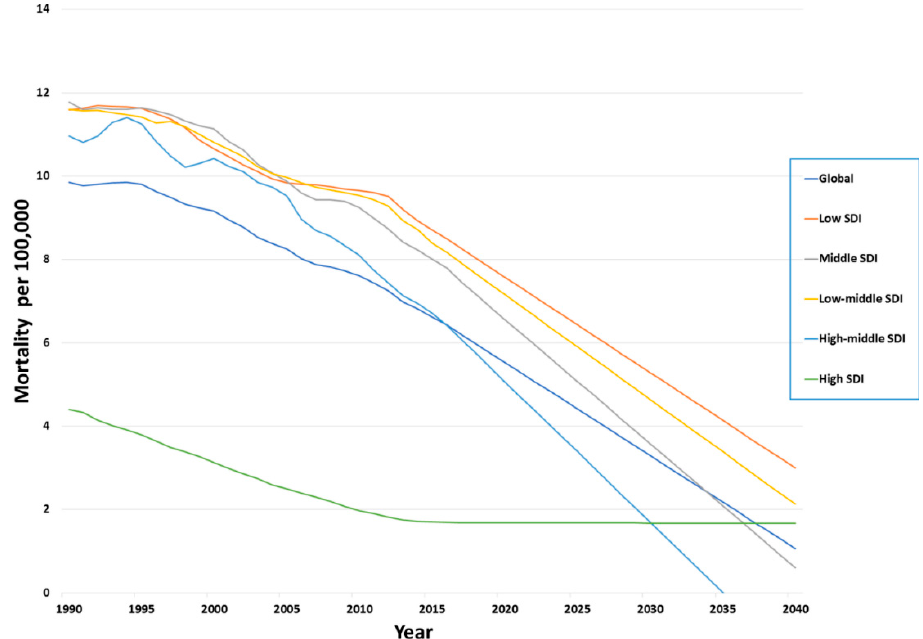
Figure 6. Forecasted trends for age-standardized mortality rates for pedestrian road traffic injuries per 100,000 across sociodemographic indices 1990 – 2017.